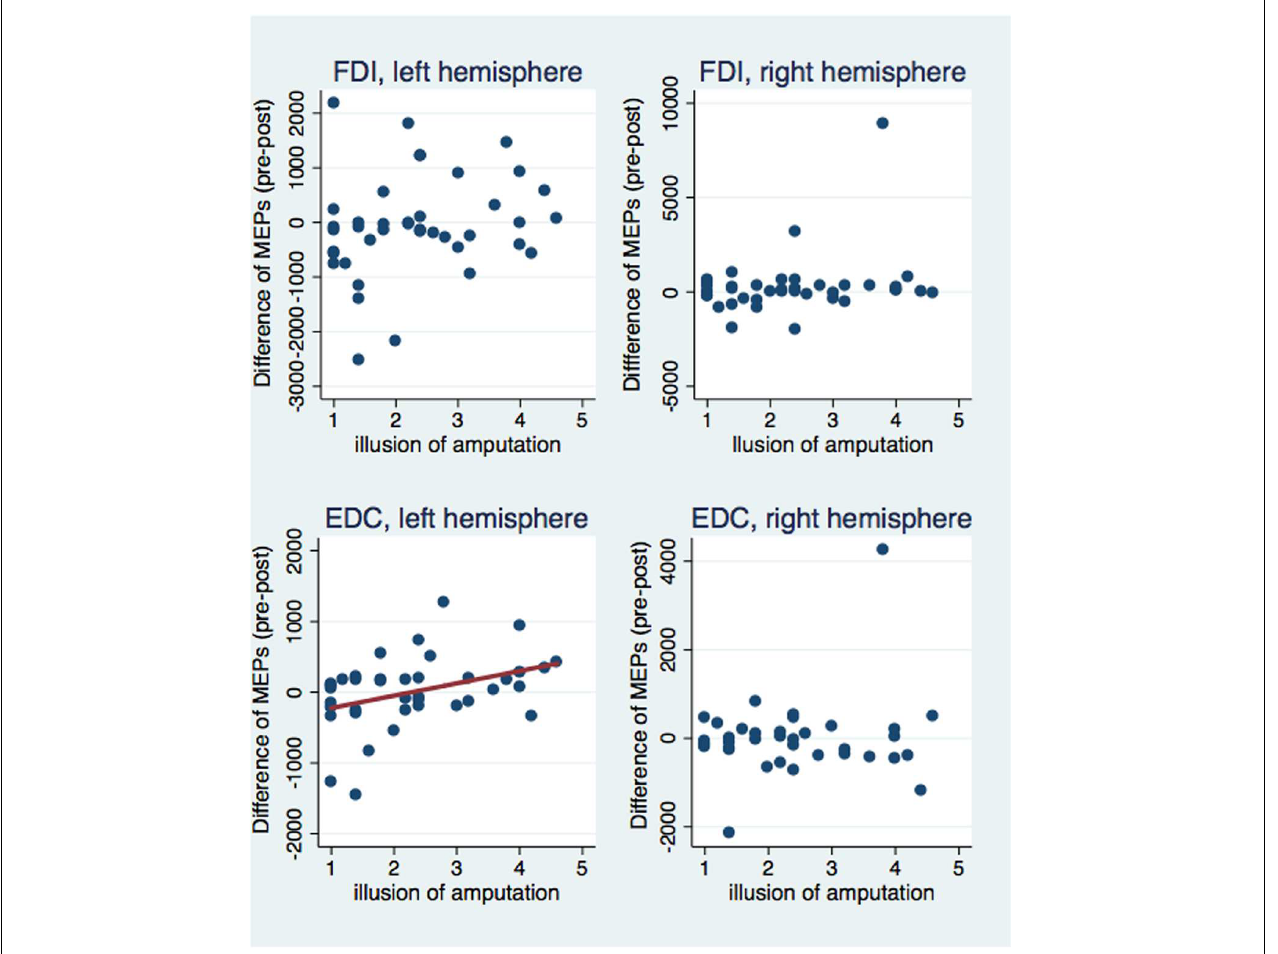
FIGURE 5 | Scatterplot of the difference between pre and post-VR MEP amplitudes with the illusion of amputation per each muscle and hemisphere. The difference in amplitudes was significantly correlated with the amputation illusion only for the EDC muscle of the left hemisphere (see text). Similarly, only in this case, the amputation illusion predicted significantly the MEPs’ difference ( b = 174.33, t = 2.53, p = 0.016) and explained a significant proportion of its variance [ R 2 = 0.12, F ( 1 , 37 ) = 6.39, p =